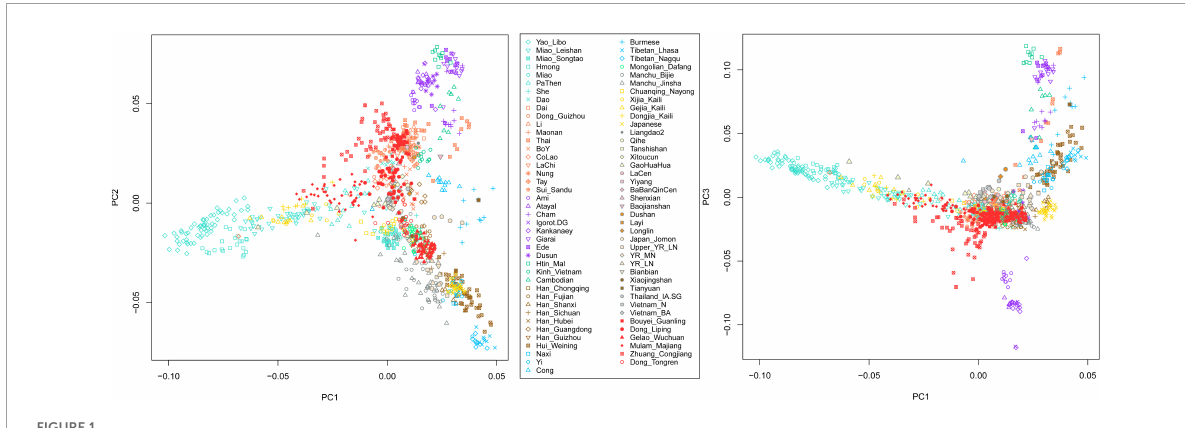
FIGURE1 Principal component analysis between the Tai-Kadai-speaking group in Guizhou and other